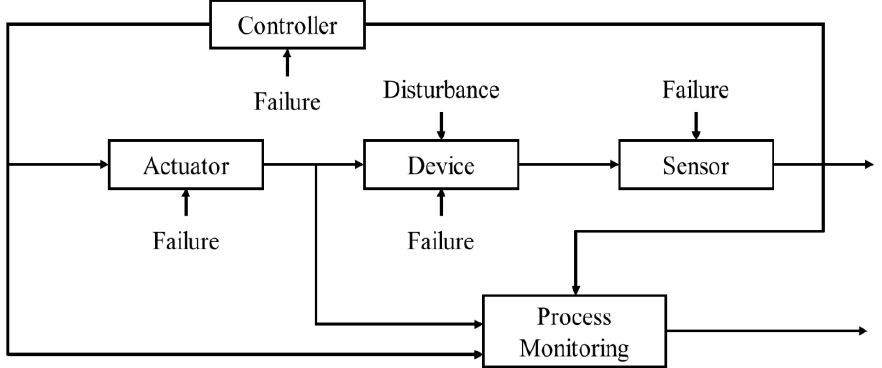
Figure 1. Failures in chemical processes.